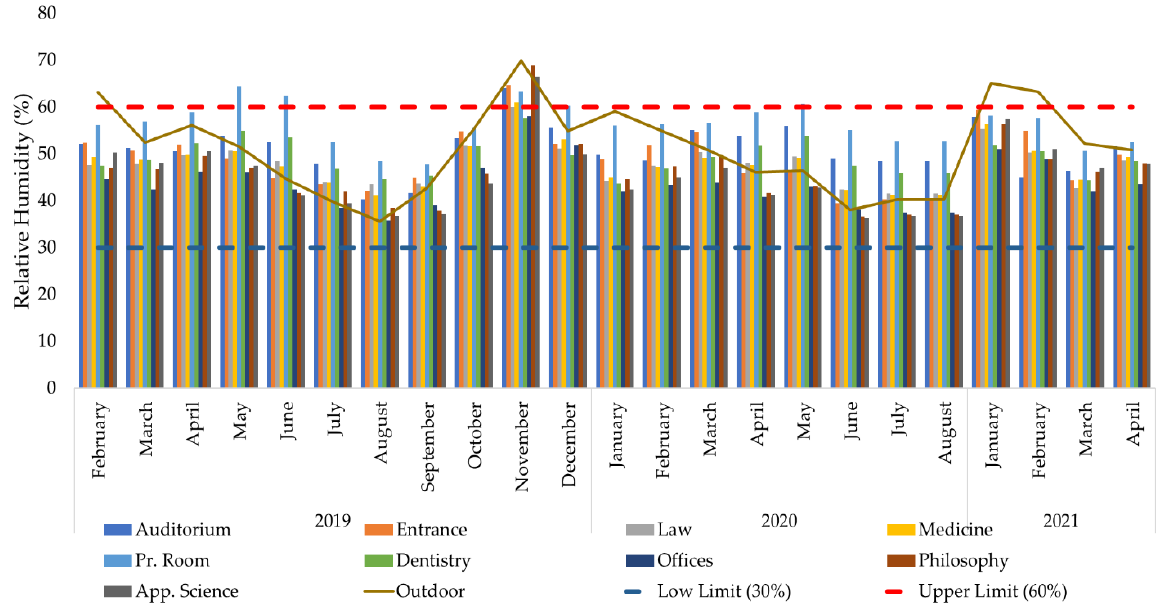
Figure 5. Mean monthly relative humidity (%) values within the museum along with the respective limits.